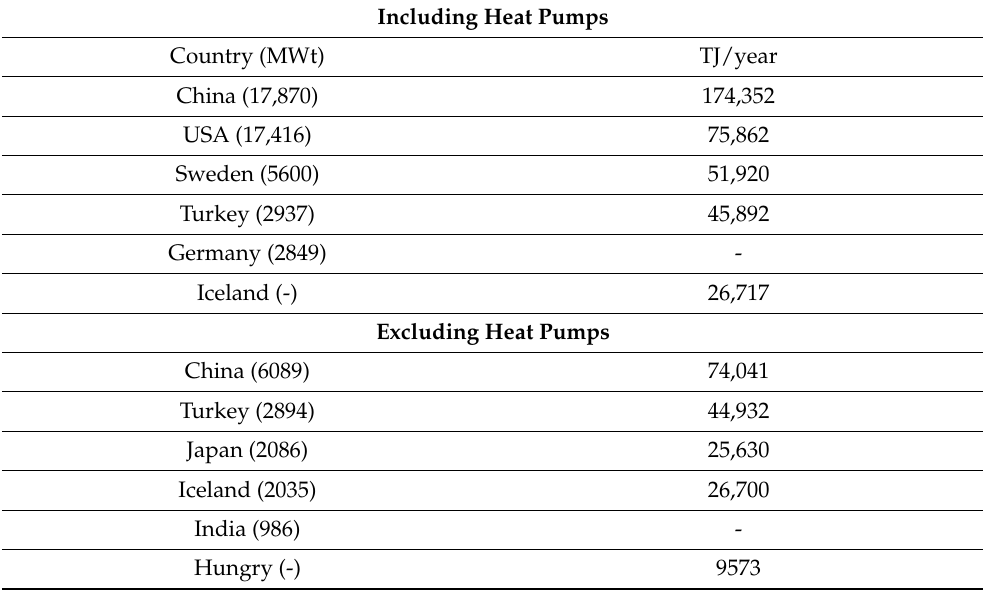
Table 4. Ranking of the countries utilizing direct geothermal energy (including and excluding heat pumps-2015